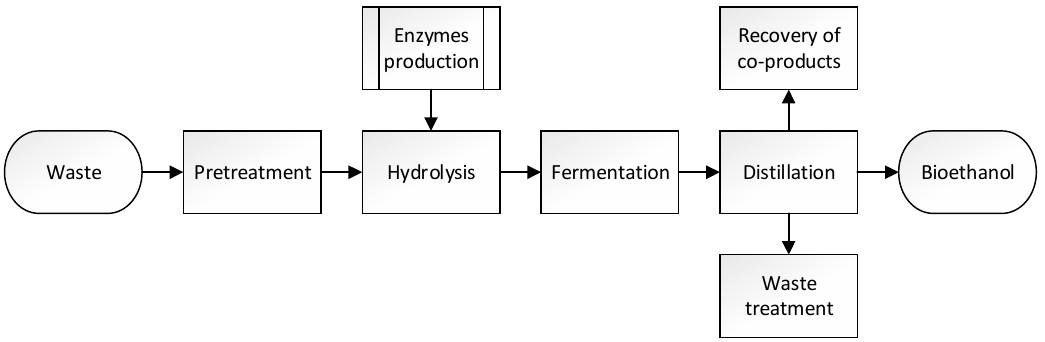
Figure 2 . Simplified diagram of the bioethanol production process . Figure 2. Simplified diagram of the bioethanol production